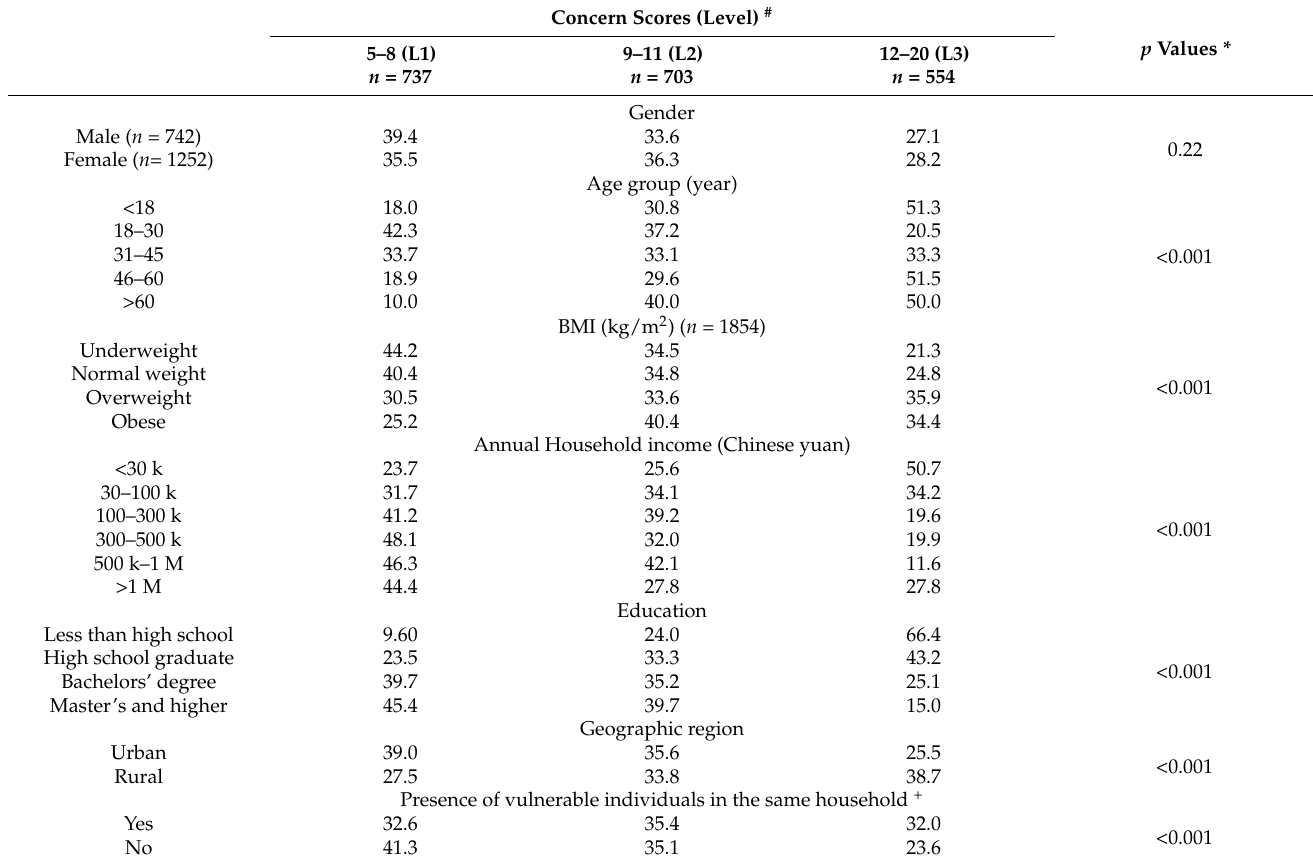
Table 1. Food and Nutrition Related Concerns by Socio-demographic Characteristics.